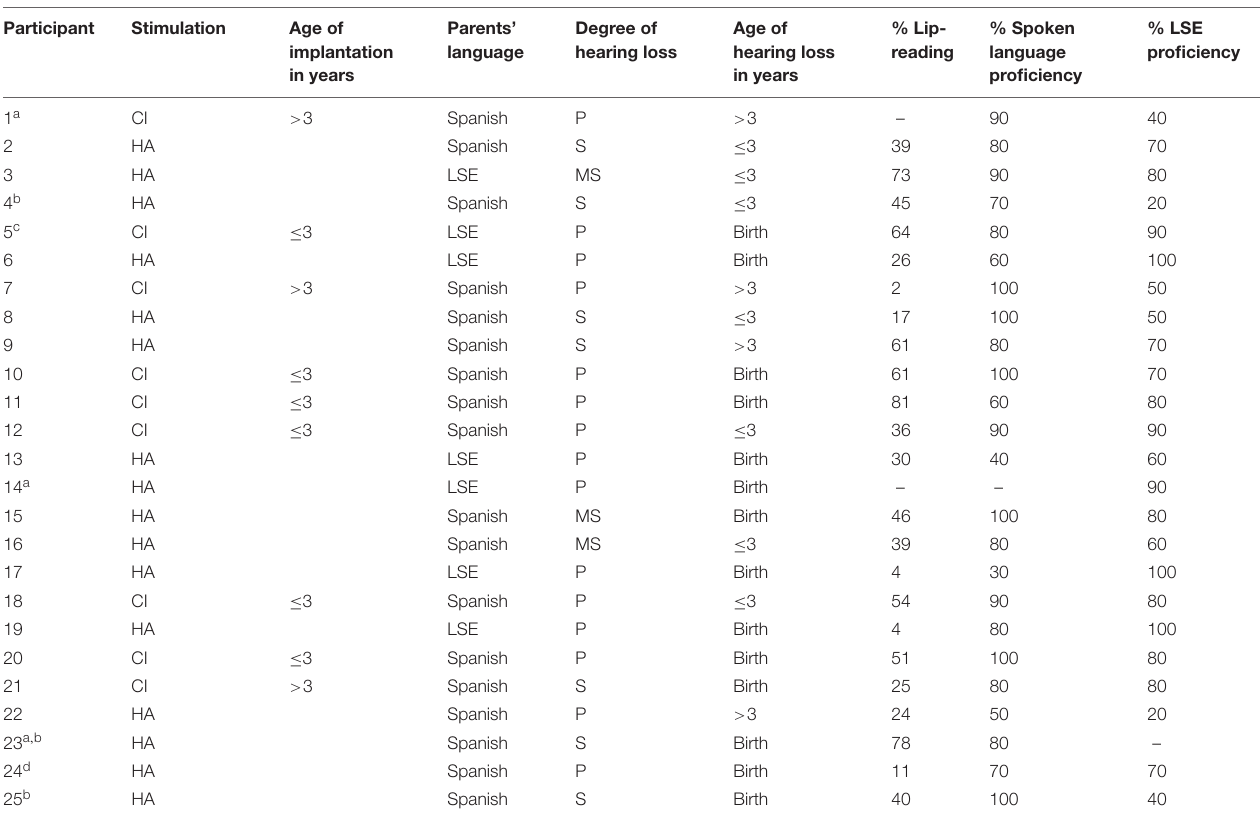
TABLE 1 | Background characteristics of deaf participants.